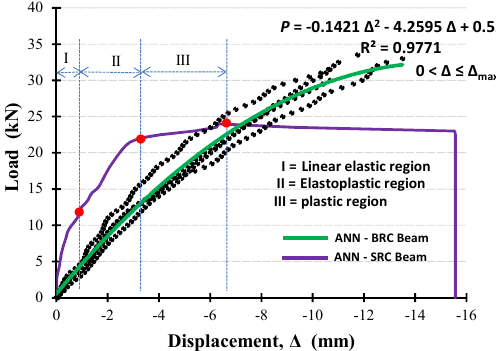
Figure 8. The load vs. deflection relationship of the BRC beam from the ANN method.